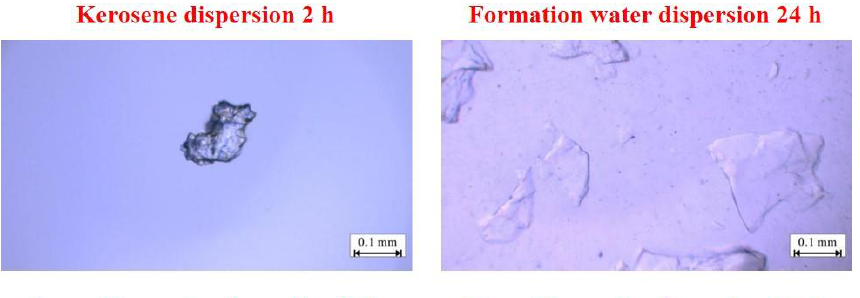
7 of 22 Figure 2. Micrograph of microspheres (WQ-100) after dispersion.